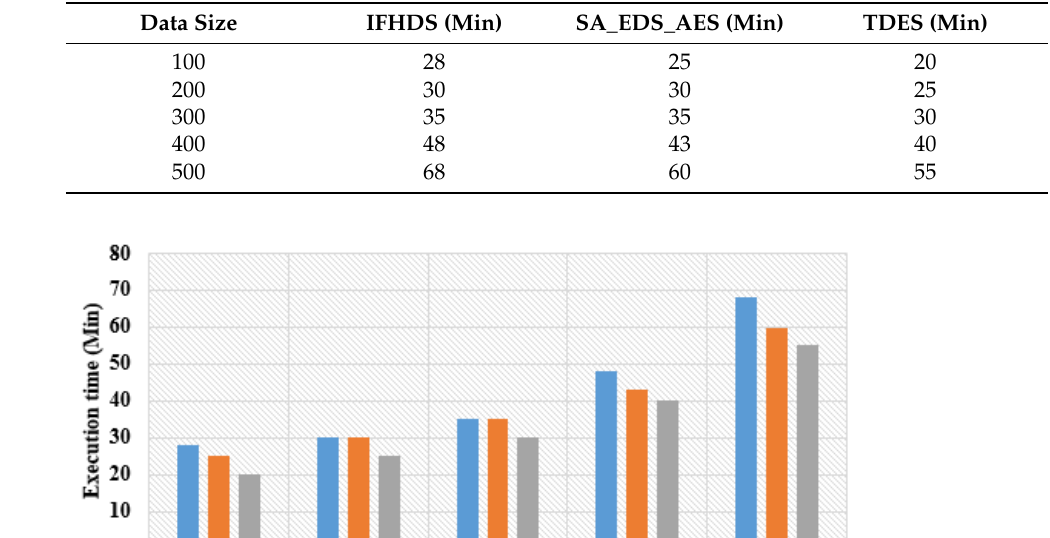
Table 5. Network usage of TDES is compared with existing techniques.